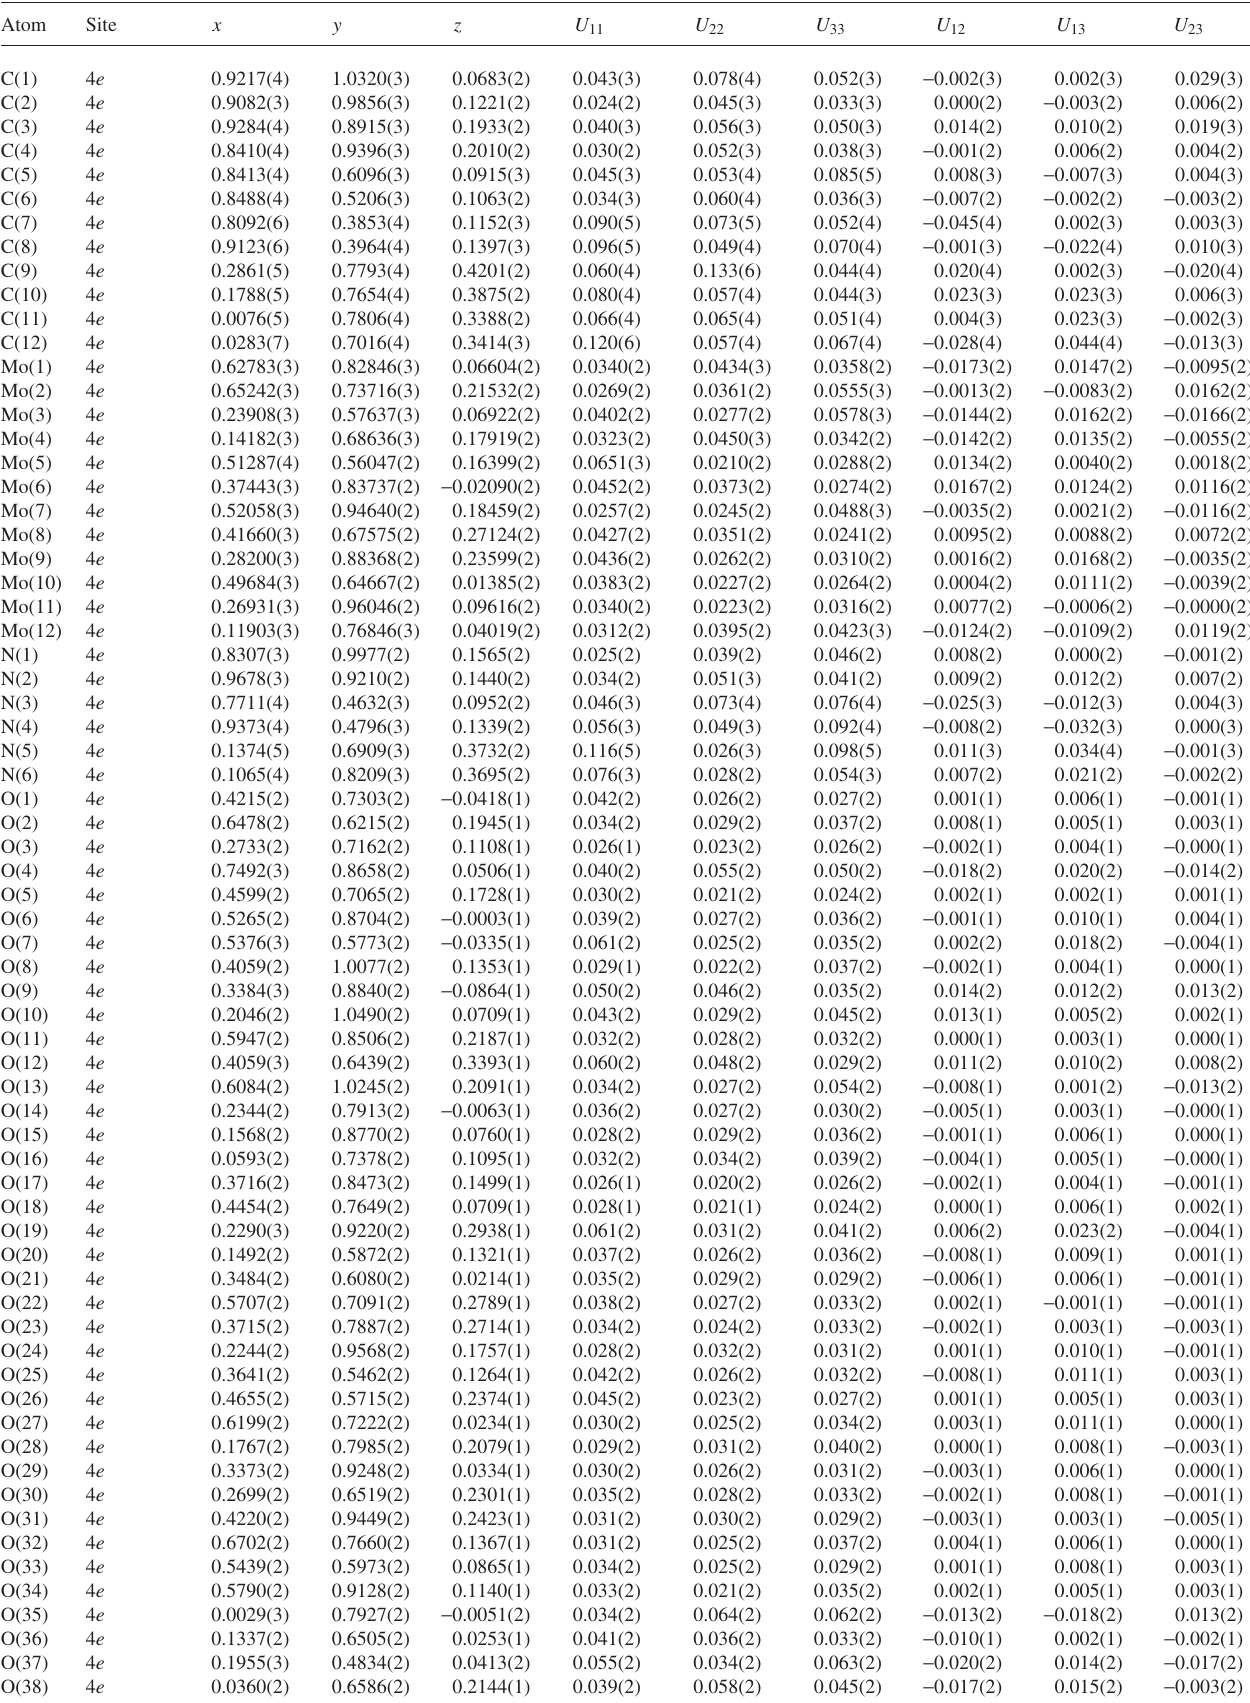
Table 3. Atomic coordinates and displacement parameters (in Å 2 )